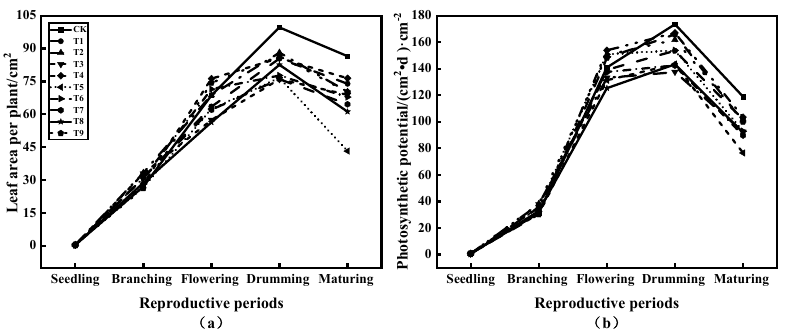
Figure 5. Leaf area and photosynthetic potential of mung bean plants at different